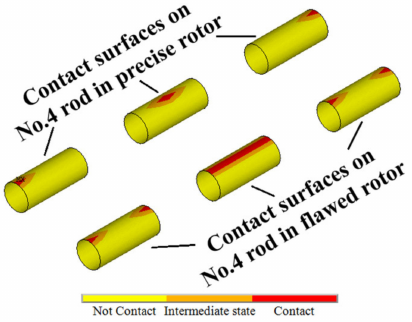
Figure 5. Contact status of rod surfaces in both